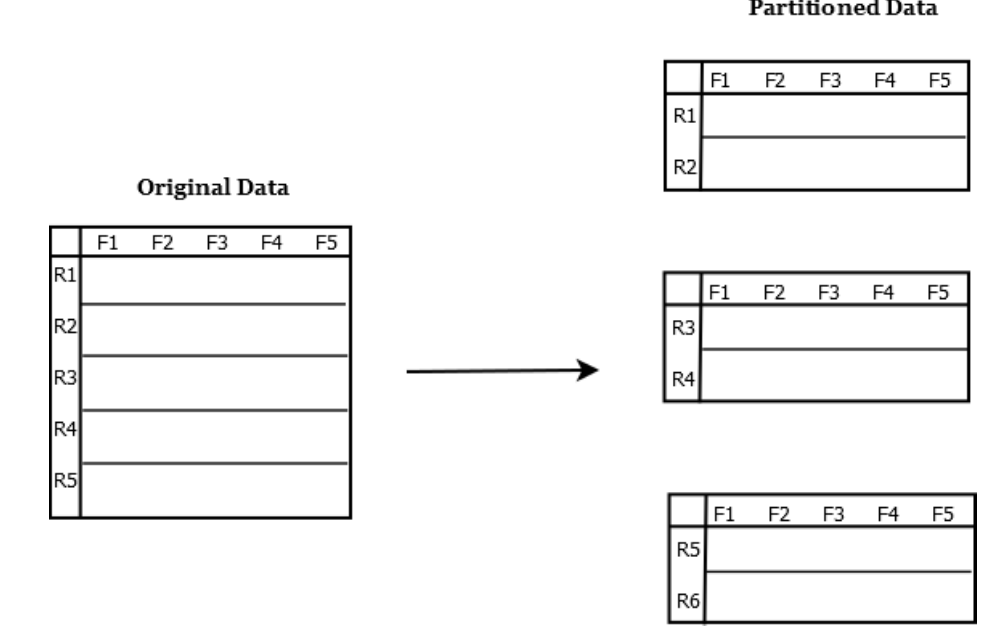
Figure 10. Data partitioning in distributed model.